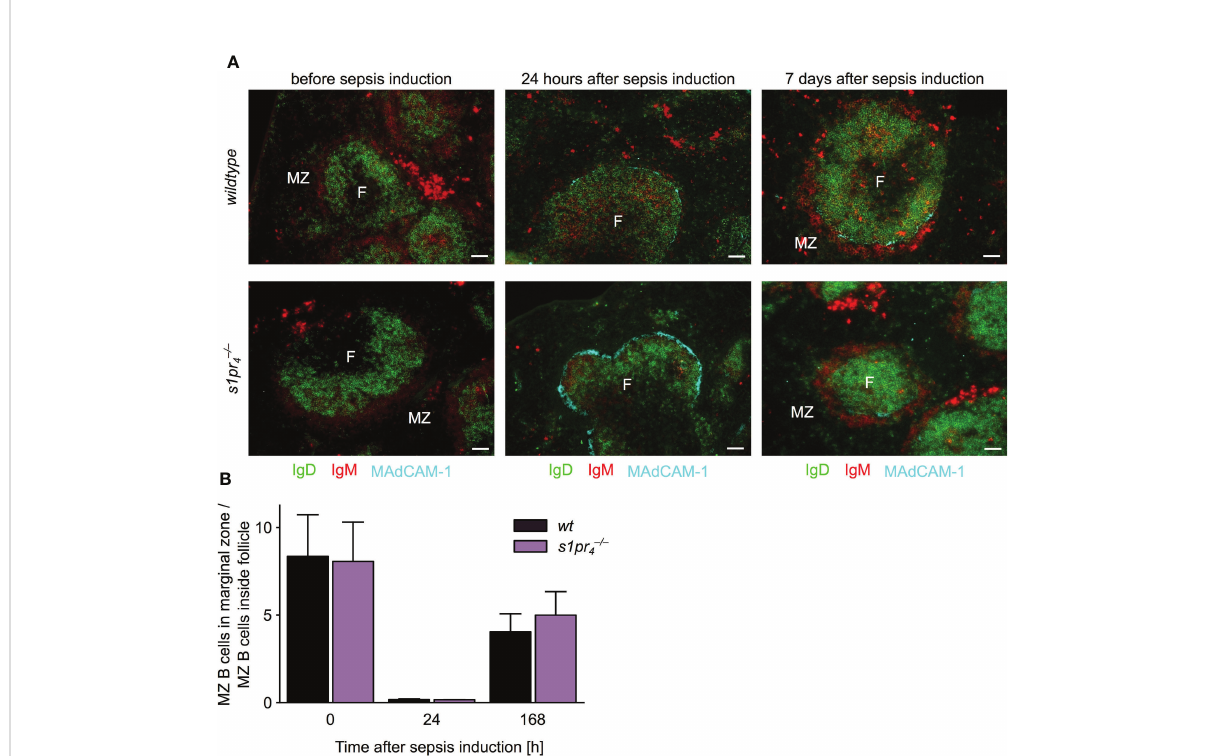
FIGURE 5 Follicular shuttling of MZ B cells in polymicrobial abdominal sepsis. (A) Spleens of mice before, one and seven days after sepsis induction were stained for marginal zone (MZ) B cells. MZ B cells were identi fi ed as IgD – IgM + . Before sepsis induction, MZ B cells are located in a red IgM + positive ring outside of green IgD + follicles (F). Twenty-four hours after sepsis induction, most MZ B cells moved into the follicle and behind the turqoise MAdCAM-1 + marginal sinus. Seven days after the induction, MZ B cells oscillated back into the marginal zone as evidenced by the re- apparance of the perifollicular IgM + cells. Representative images of n = 5 animals per group are shown. White scale bar equals 50 µm. (B) Quantitative analysis of MZ B cell shuttling during polymicrobial abdominal sepsis. The ratio represents the proportion of MZ B cells localized in the marginal zone to MZ B cells localized in the white pulp (n = 5; mean + standard